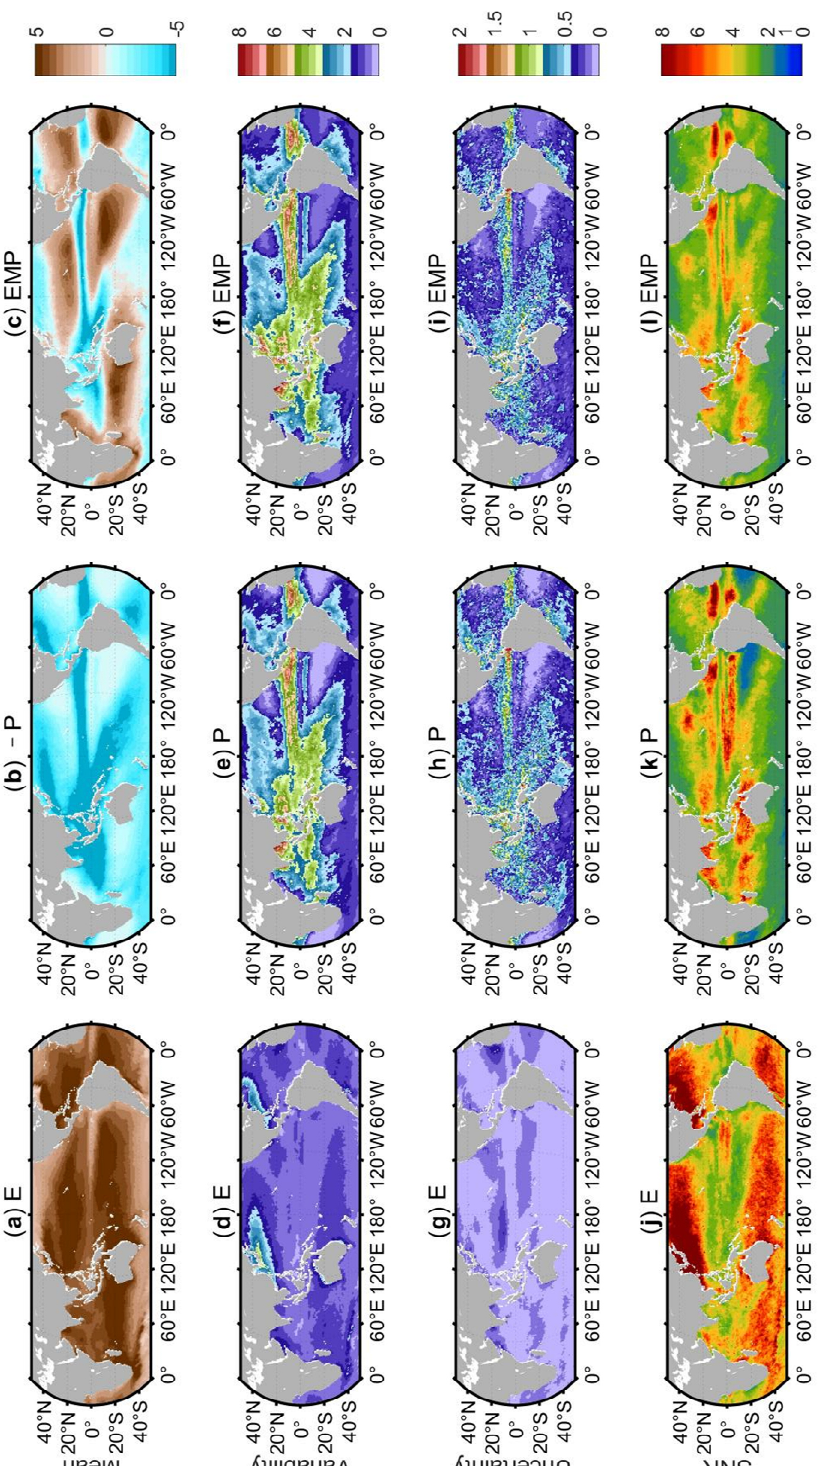
Figure 1. Climatological mean of ( a ) E , ( b ) negative P and ( c ) EMP derived from the ensemble median over 2012–2017; ( d – f ) variability, ( g – i ) uncertainty, and ( j – l ) are signal-to-noise ratio maps of E , P , EMP, respectively. The units for mean, variability and associated uncertainty are mm/day, and SNRs are unitless.